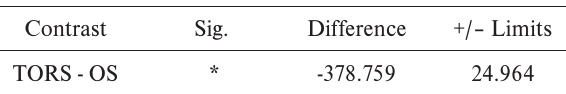
Table 1. Blood loss – statistical difference between tested